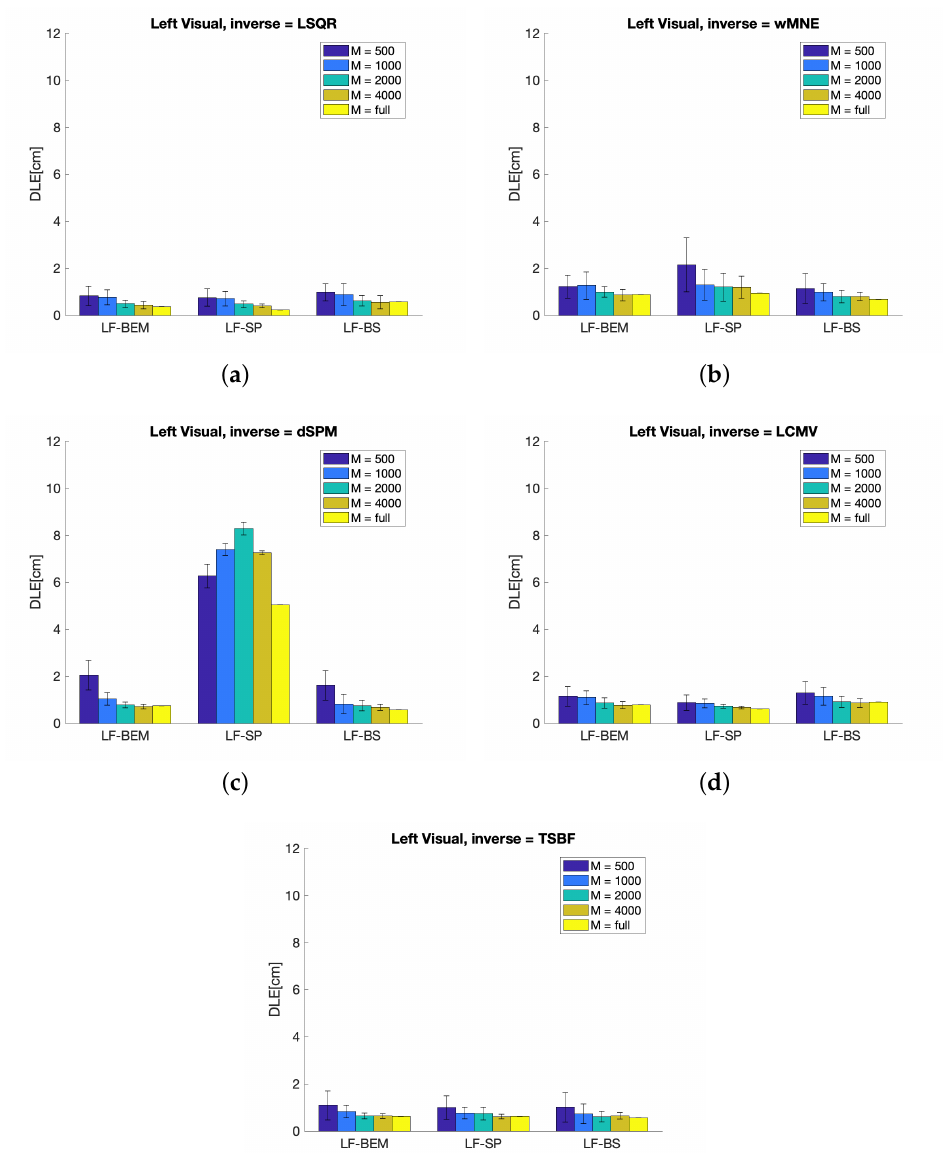
Figure 4. Left Visual evoked field: Mean DLE [cm] and standard deviation obtained averaging over N = 10 runs using LSQR ( a ), wMNE ( b ), dSPM ( c ), LCMV ( d ), and TSBF ( e ) at 90 ms for LF-BEM, LF-SP, and